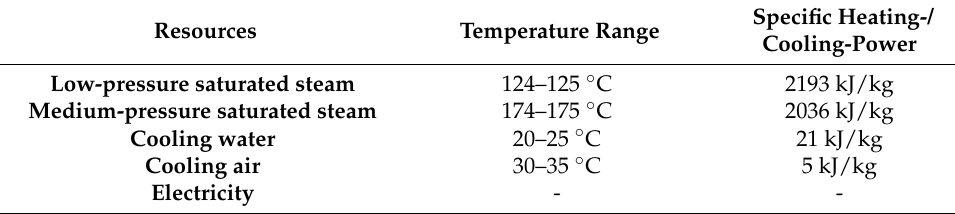
Table A2. Resources used.